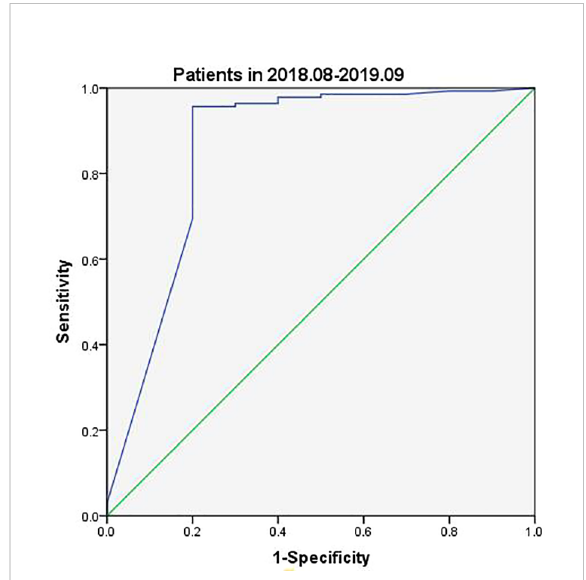
FIGURE 3 The ROC curves of FNA-Tg in different assay kits of Tg (Patients in 2018.08-2019.09).